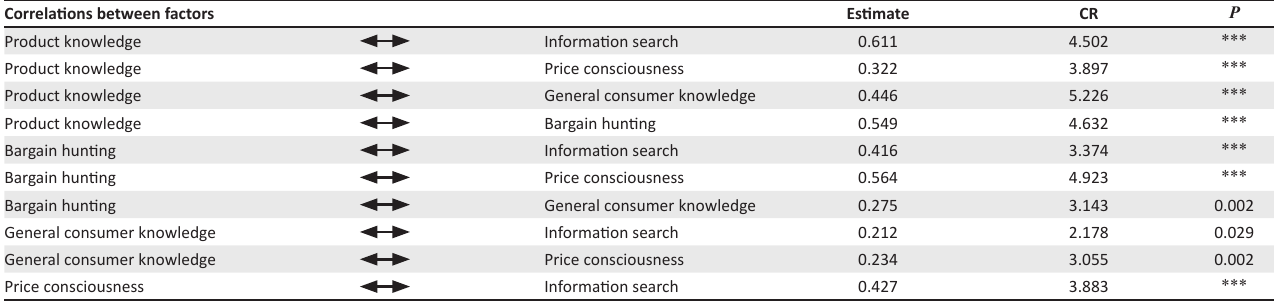
TABLE 5: Correlations between dimensions of consumer awareness. Correlations between factors